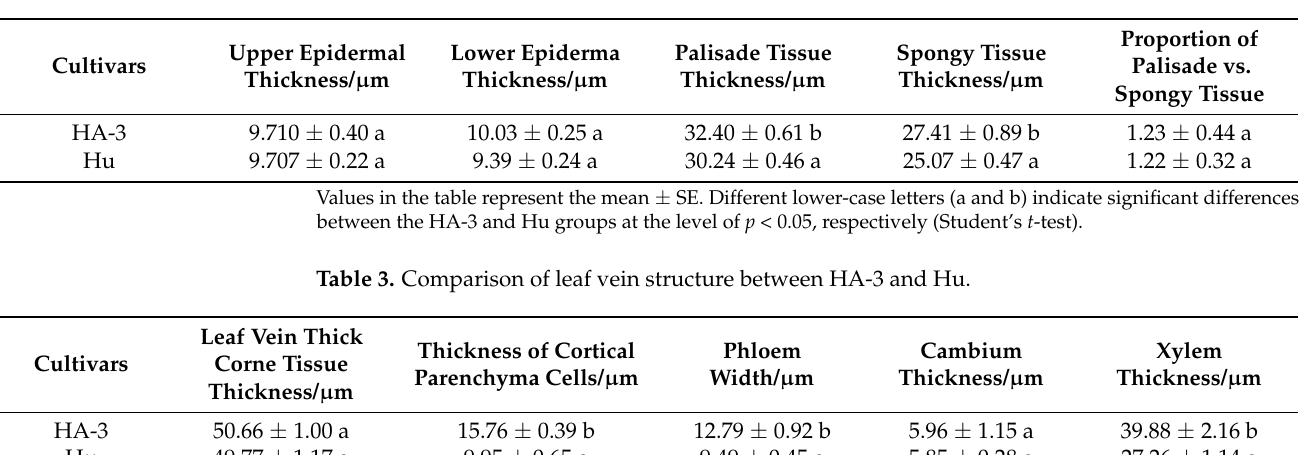
Values in the table represent the mean ± SE. Different lower-case letters (a and b) indicate significant differences between the HA-3 and Hu groups at the level of p < 0.05, respectively (Student’s t -test). Table 2. Comparison of epidermis and mesophyll structures between HA-3 and Hu.